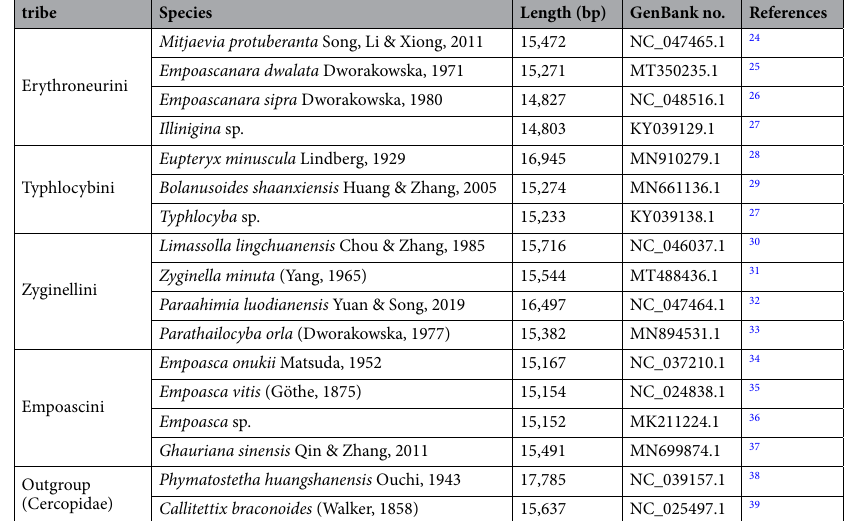
Outgroup Table 2. Sequence information of 17 species of Typhlocybinae and one outgroup downloaded from GenBank.